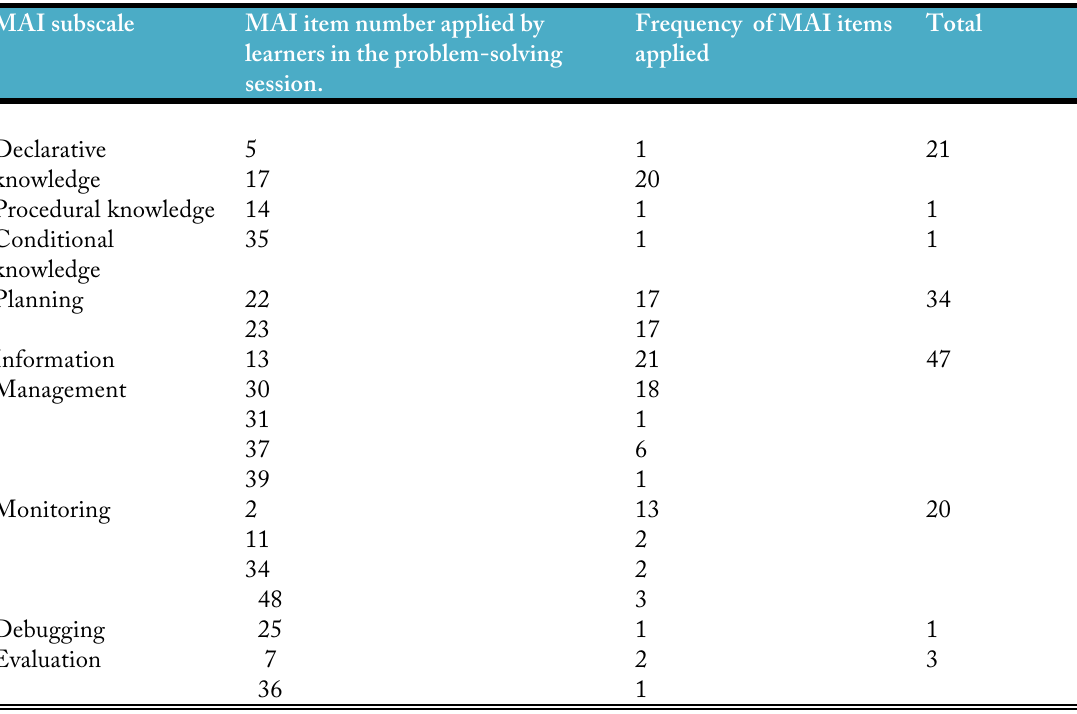
The level of learner metacognition applied in the problem-solving session MAI subscale MAI item number applied by